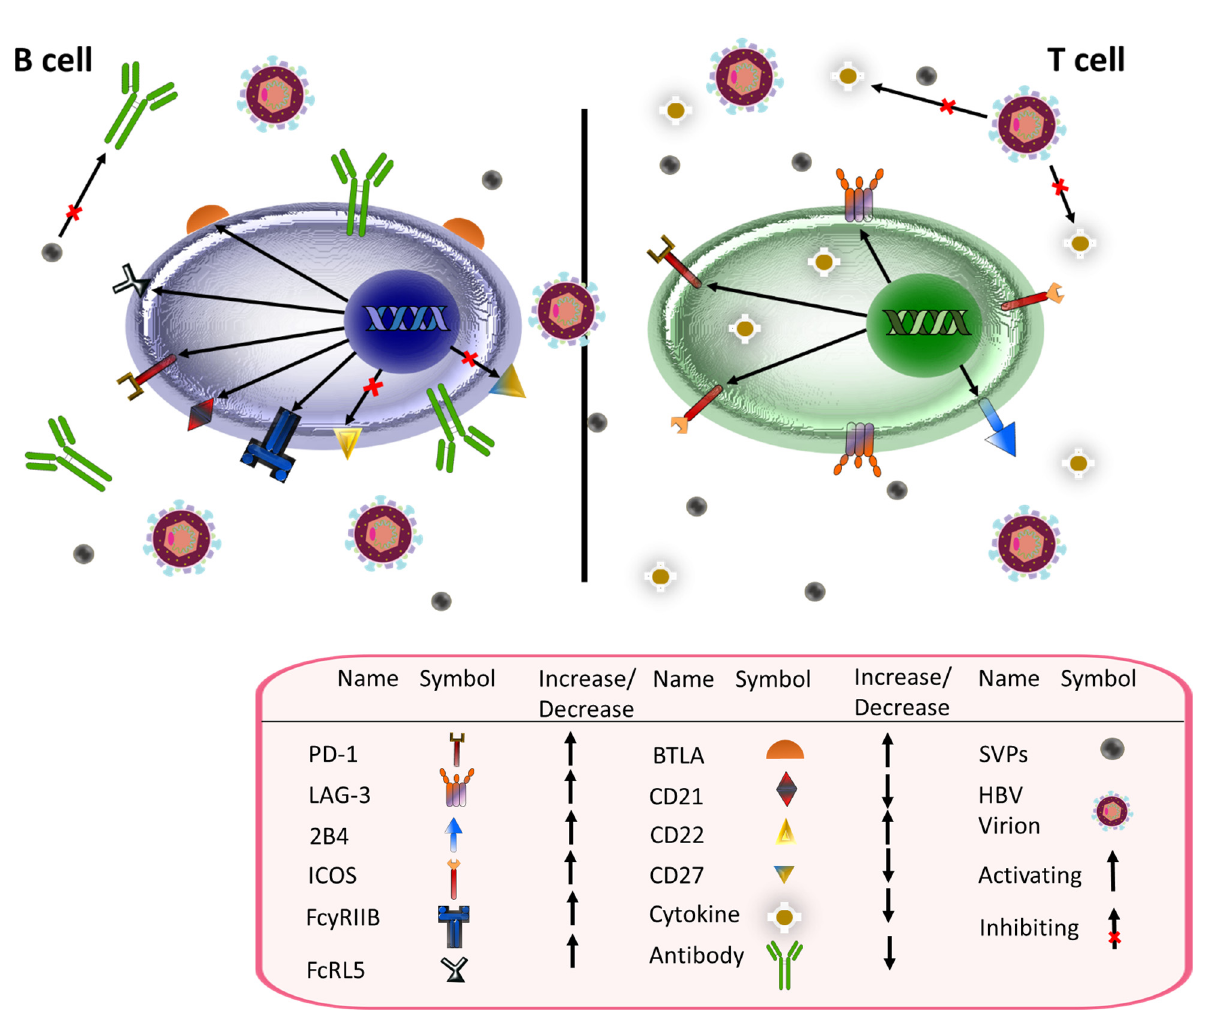
Figure 3. Chronic HBV-induced phenotypic changes in B ( left ) and T ( right ) cells. HBV infection results in several phenotypic changes in B and T cells. In B cells, it inhibits expression of CD21 and CD27 and increases the proportion of atypical memory B cells, which are dysfunctional B cells that express higher levels of inhibitory receptors such as PD-1 and FcRL5. In addition, HBV infection inhibits anti-HBs antibody production. Subviral particles (SVPs), the majority of which include HBsAg, adversely impact the efficacy of circulating antibodies. Like with B cells, HBV stimulates T cell expression of inhibitory receptors including PD-1 and LAG-3. In addition, regulatory T cell (Treg) markers such as ICOS are elevated. Cytokine and interleukin expression is also impaired. In the above figure, black arrows represent upregulation while black arrows with an x represent